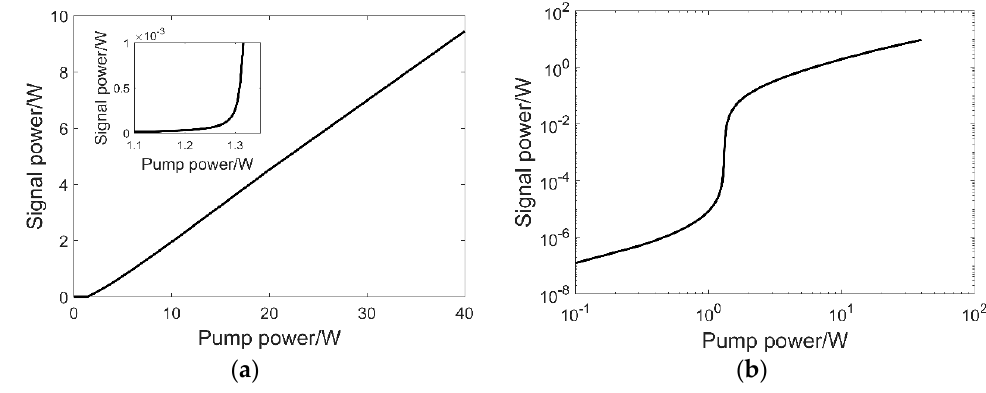
Figure 6. Numerically calculated dependence of the output signal power on the pump power for a 2 m fiber length and 0.2 reflectivity for signal at z = L : ( a ) Presented on a linear scale. The inset shows zoomed region near the lasing threshold; ( b ) Presented on a logarithmic scale.